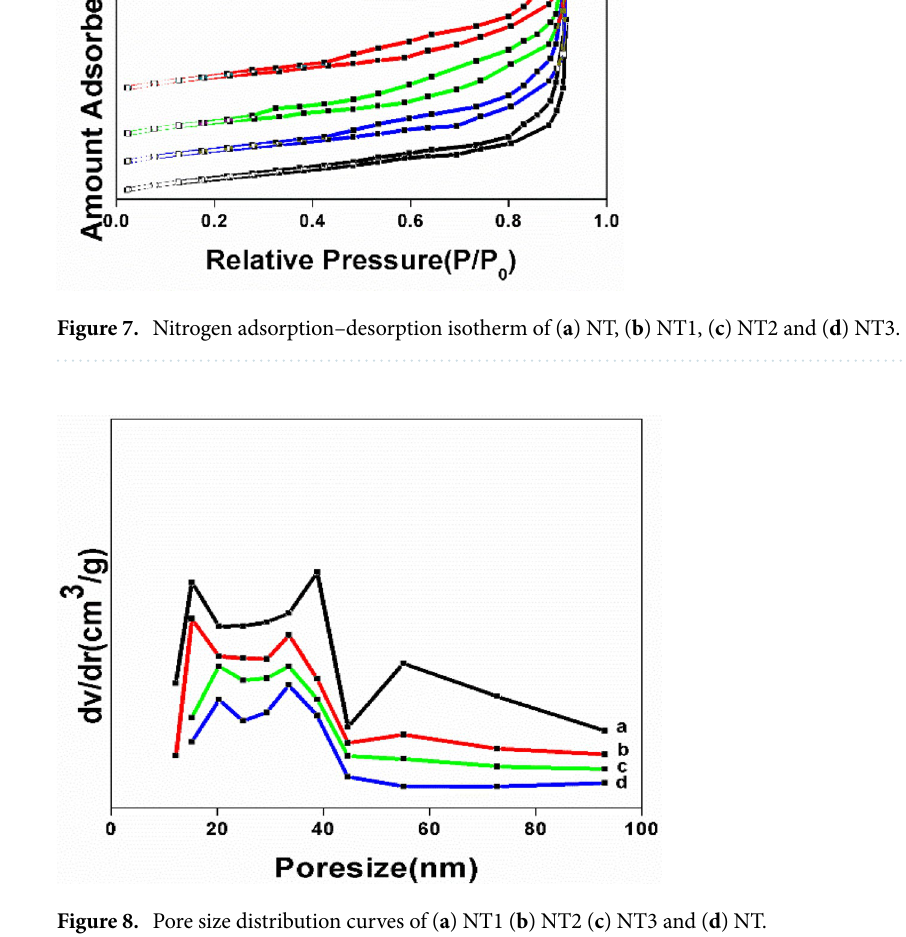
Figure 8. Pore size distribution curves of ( a ) NT1 ( b ) NT2 ( c ) NT3 and ( d )